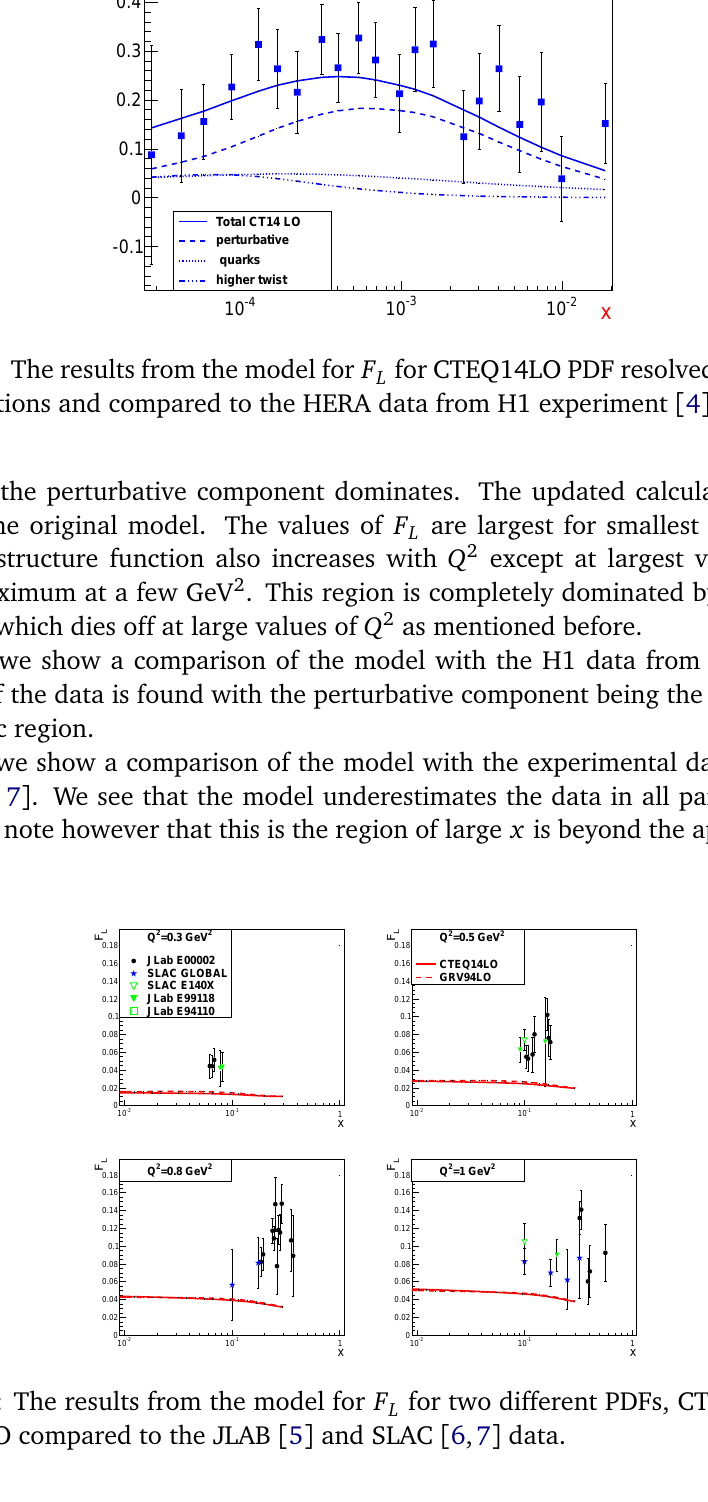
for two different PDFs, CTEQ14LO and L